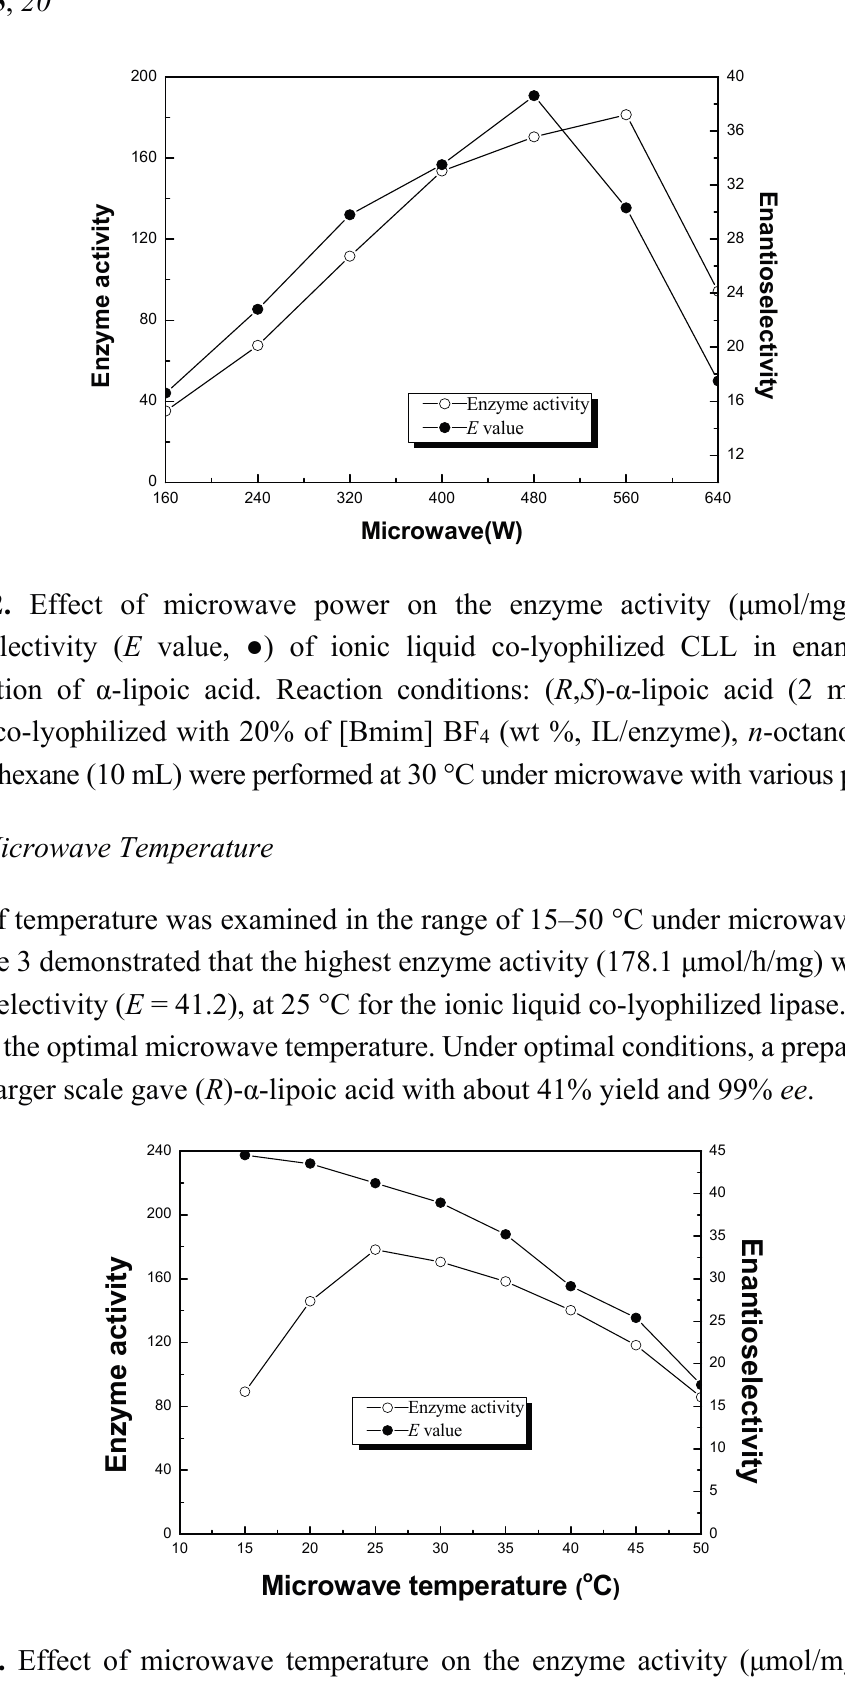
Figure 3. Effect of microwave temperature on the enzyme activity ( μ mol/mg/h, ○ ) and enantioselectivity ( E value, ● ) of ionic liquid co-lyophilized CLL in enantioselective esterification of α -lipoic acid. Reaction conditions: ( R , S )- α -lipoic acid (2 mmol), CLL (10 mg) co-lyophilized with 20% of [Bmim] BF 4 (wt %, IL/enzyme), n -octanol (5 mmol) and cyclohexane (10 mL) were performed at different temperature under microwaves (480